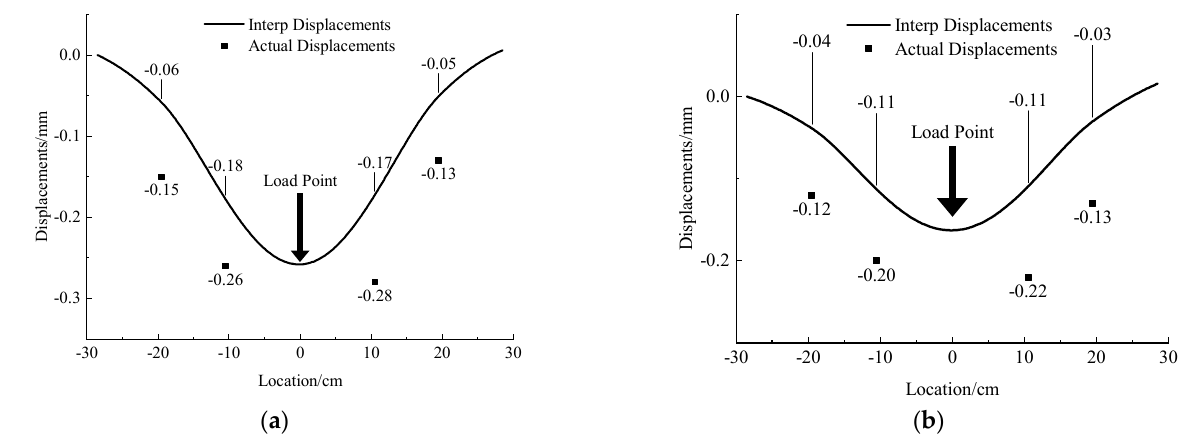
Figure 8. Deformation curve and measured displacement of single steel tunnel with 0.1 mm and